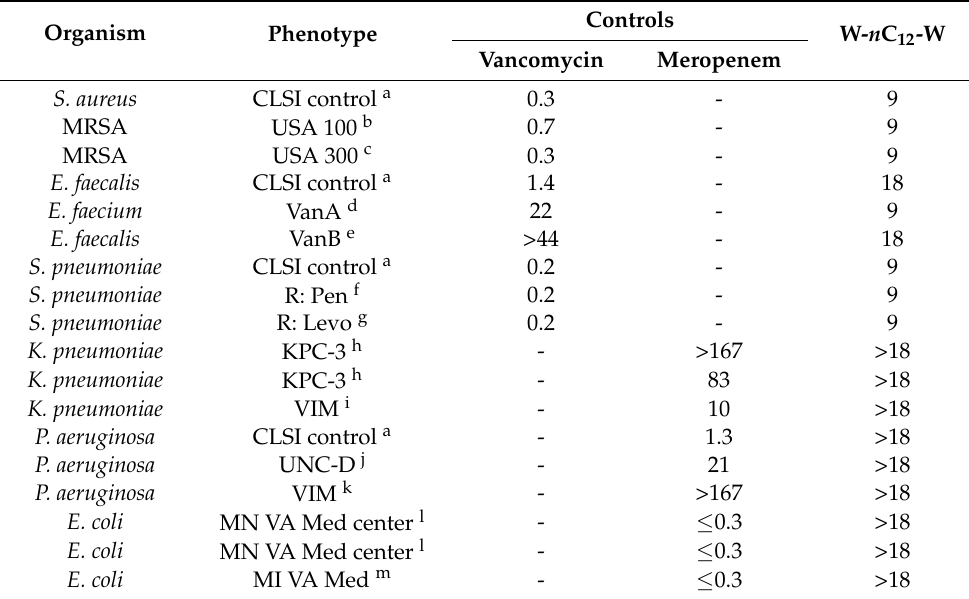
Table 2. MICs ( µ M) of W- n C 12 -W and antibiotics.